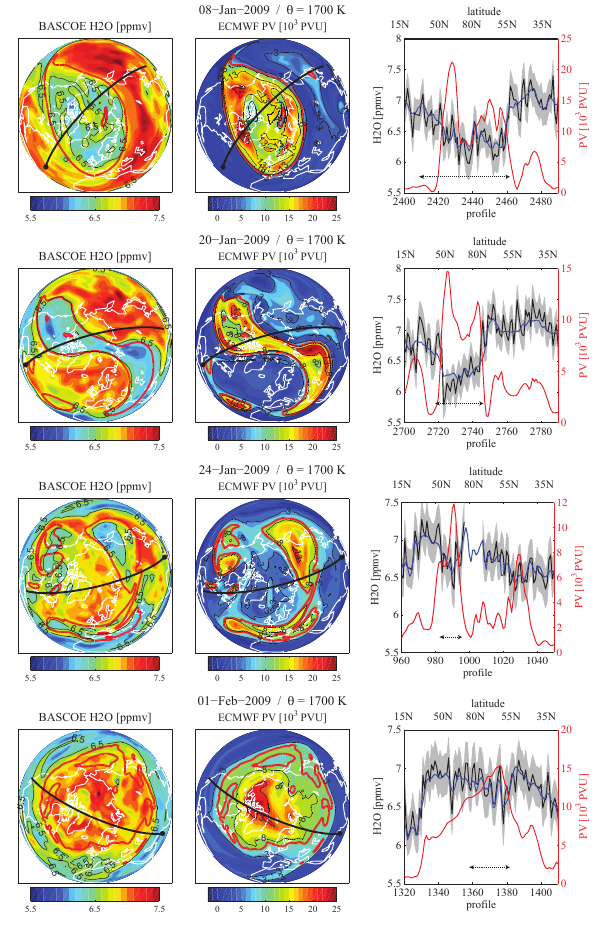
Fig. 6. As Fig. 4 but at 1700 K. The PV field is depicted in 10 3 × PV